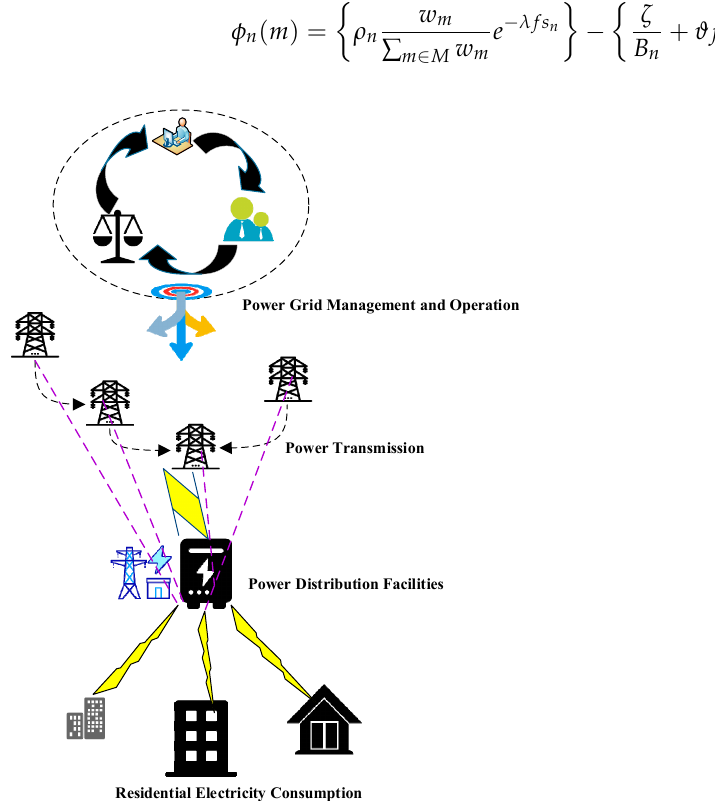
Figure 4. The architecture of the intelligent PGS-oriented PPS .